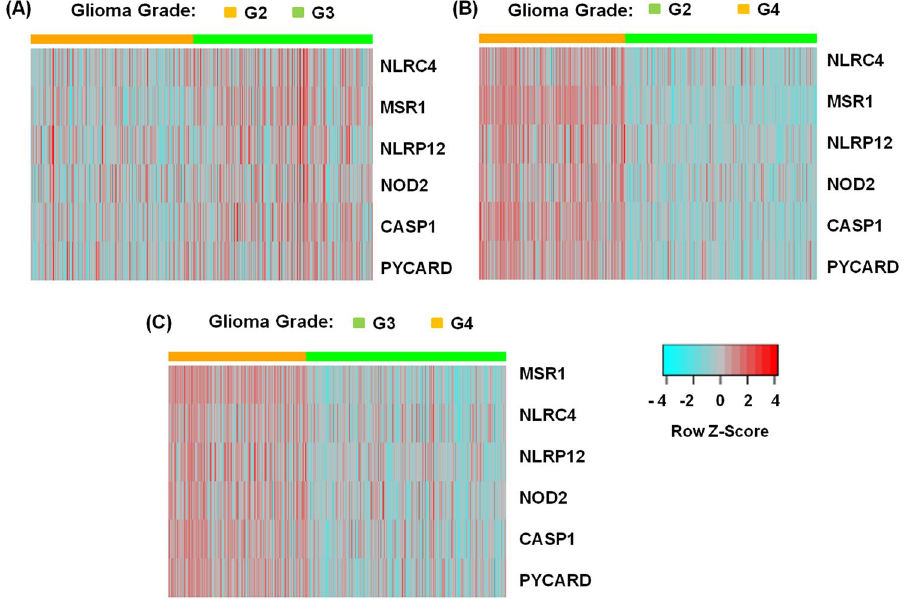
Figure 3. Heat map clustering representation for most significantly differentially expressed NLR-associated genes in glioma. We have grouped all the glioma samples by glioma grade 2, 3 and 4. Here, G2, G3 and G4 represents grade 2, grade 3, and grade 4 respectively. ( A ) Shows gene expression of most differentially expressed genes, MSR1 , NLRC4 , NLRP12 , NOD2 , CASP1 and PYCARD across the grade 2 (orange) & grade 3 (green) of LGG samples. Similarly, panel ( B , C ) shows characteristic gene expression clusters between grade 4 (orange) & grade 2 (green) and grade 4 (orange) & grade 3 (green) glioma samples respectively. The segregation of grade 4 glioma from the grade 2 and grade 3 glioma is evident as the resulting heatmaps form expression ‘blocks’. Here, relative up-regulated and down-regulated gene expression, are shown in red and blue respectively.